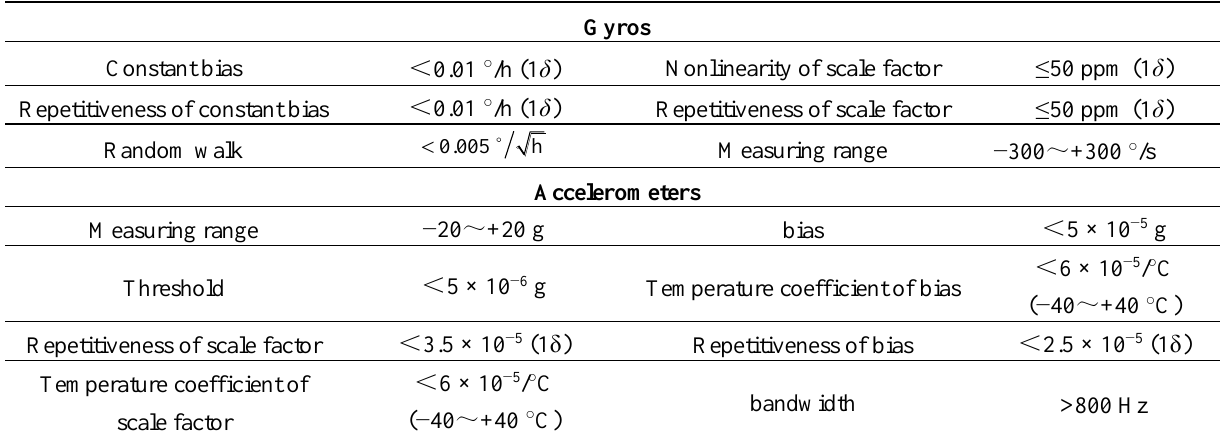
Table 1. The parameters of the gyros and